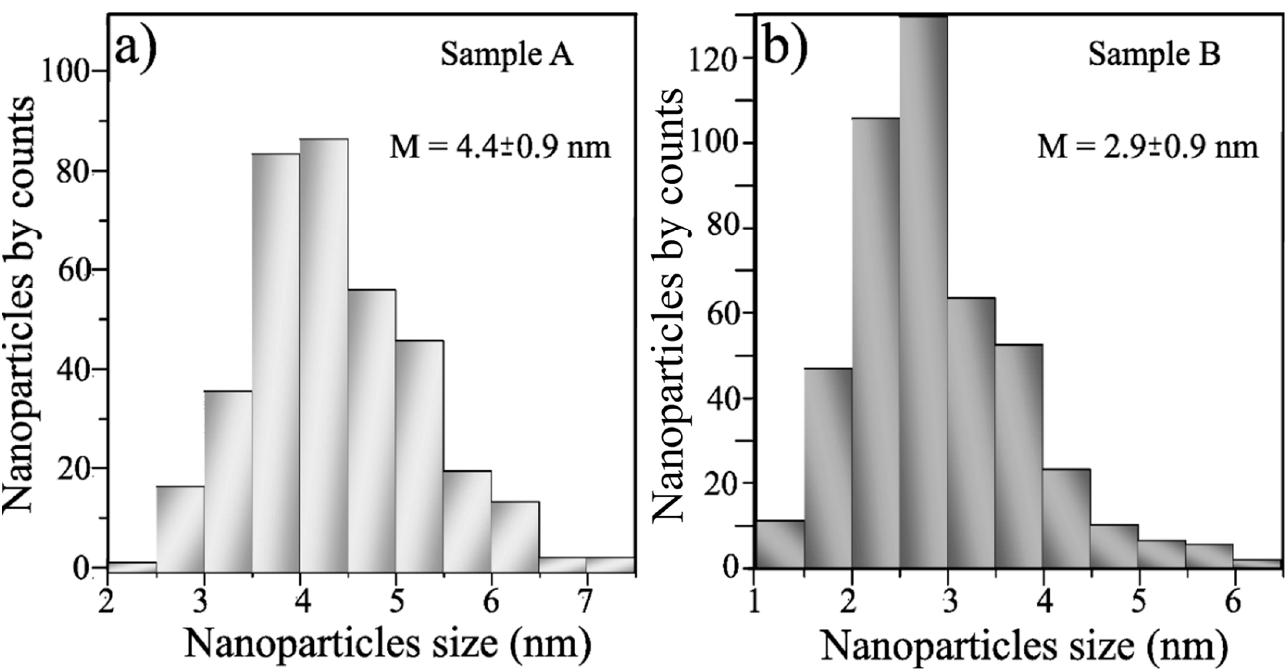
Figure 4. Histogram plots of nanoparticle size (nm) and count of ( a ) Sample A and ( b ) Sample B from the TEM images.